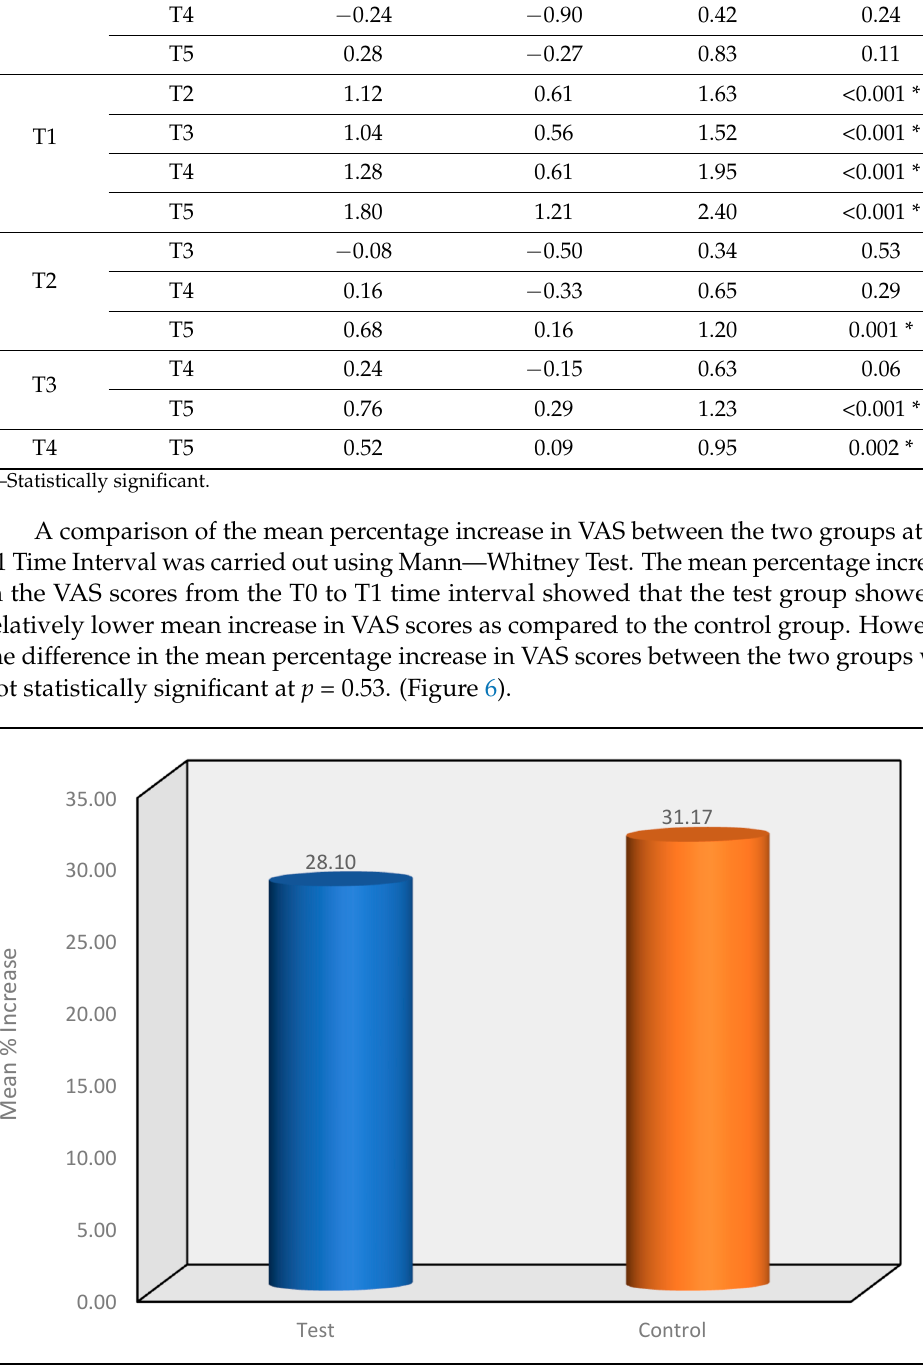
Table 5. Multiple comparison of mean difference in VAS scores b/w time intervals in the control group using the Wilcoxon signed-rank post hoc test.